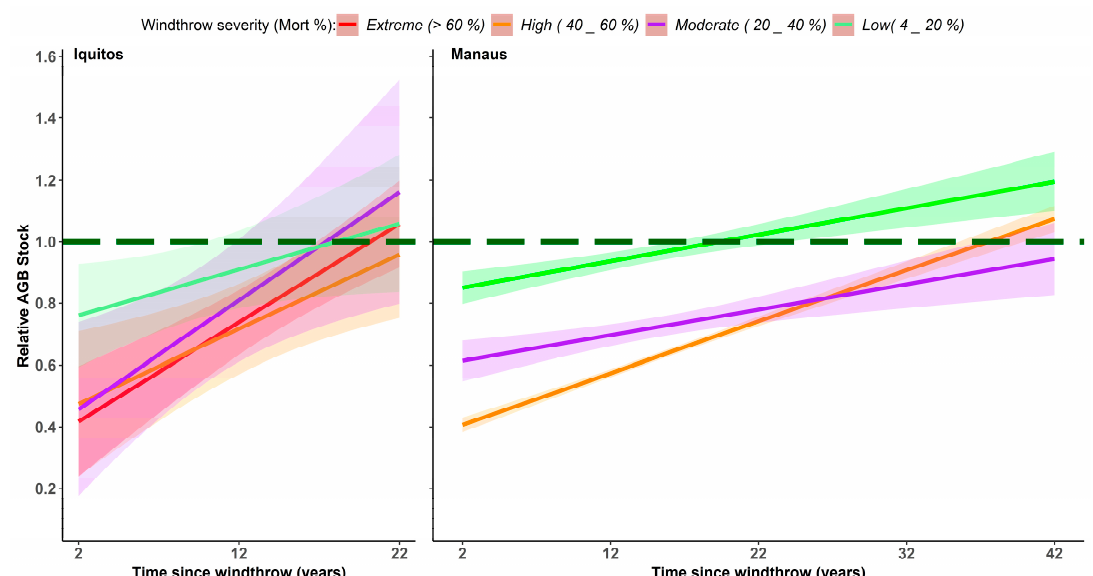
Figure 4. Chronosequences (LM CI = 90%) for AGB recovery (>90% Old-growth conditions) across a range of windthrow severities in Iquitos, Peru (Northwestern Amazon) and Manaus, Brazil (Central Amazon). The dashed dark-green line shows the old-growth condition.